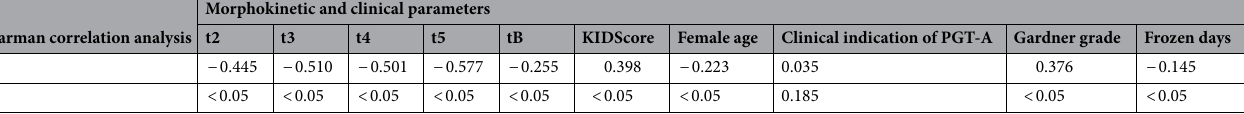
Table 4. Relationship between characteristics and euploid by Spearman correlation